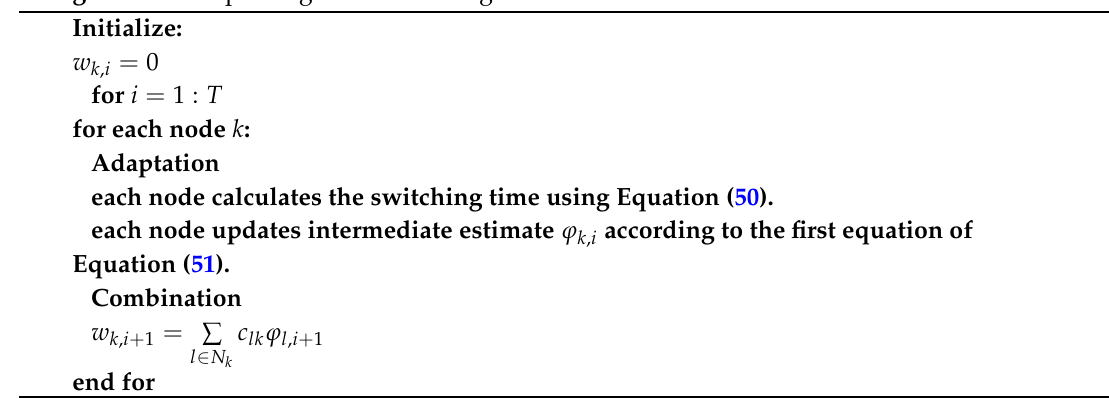
Algorithm 2: Improving DMEE-SAS Algorithm